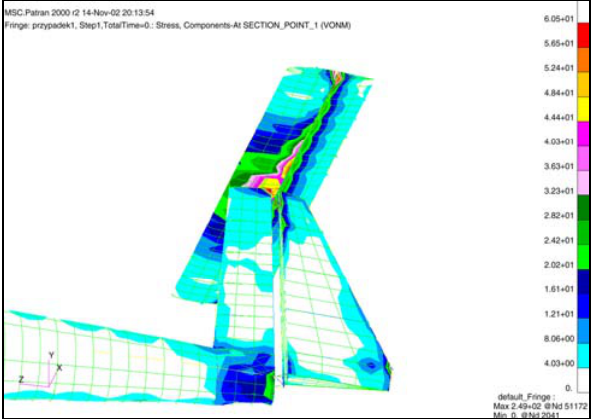
Fig 12. Effective stress concentrations (von Misses) in empennage